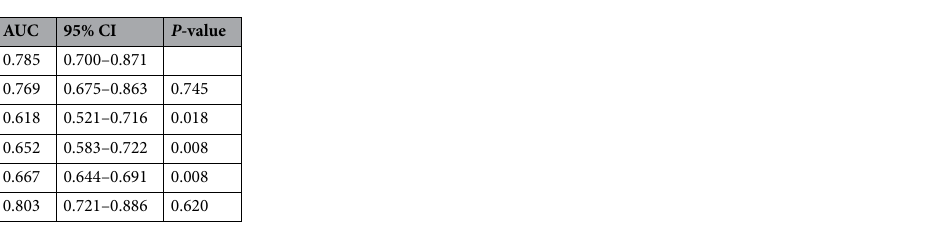
Table 3. Comparison of the risk score performance. AUC area under the curve, CI confidence